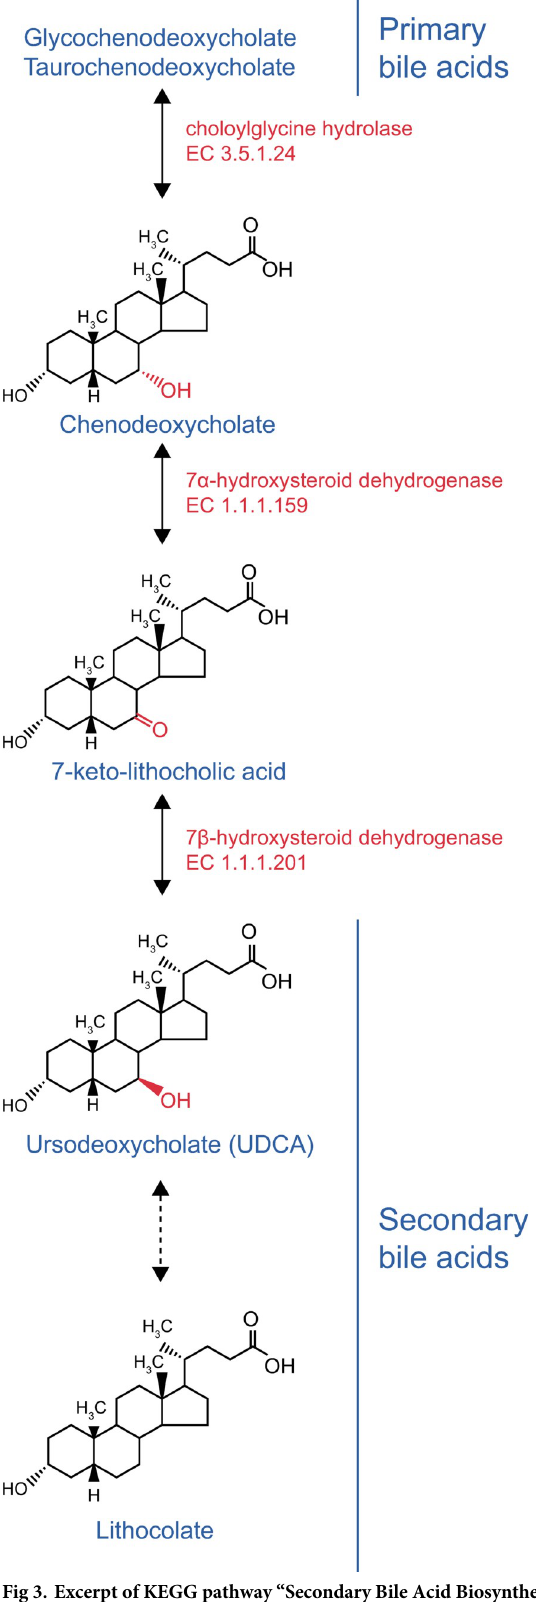
Fig 3. Excerpt of KEGG pathway “Secondary Bile Acid